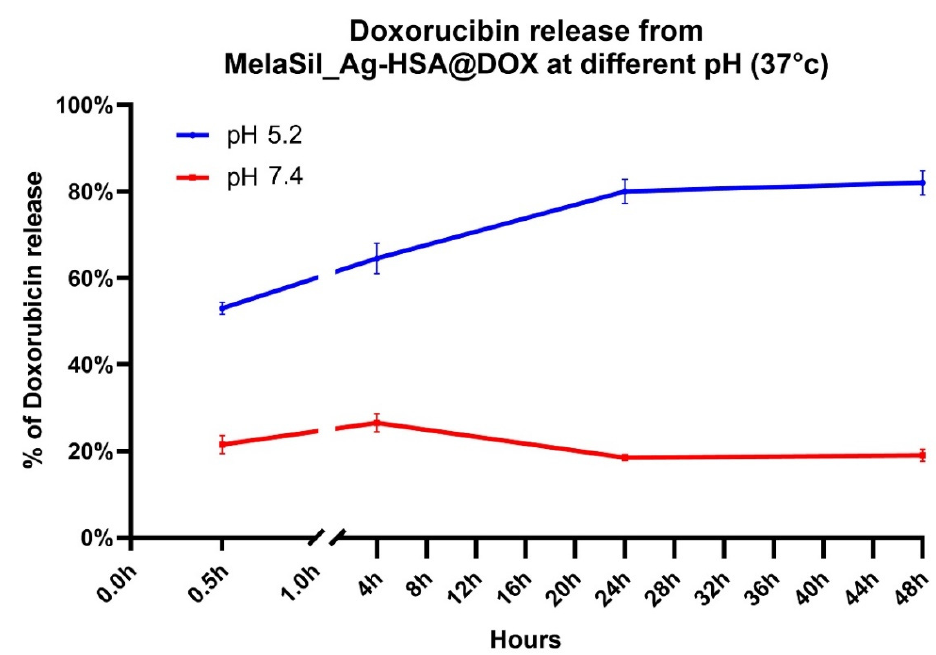
Figure 3. Doxorubicin release at pH 5.2 and pH 7.4. p < 0.05.